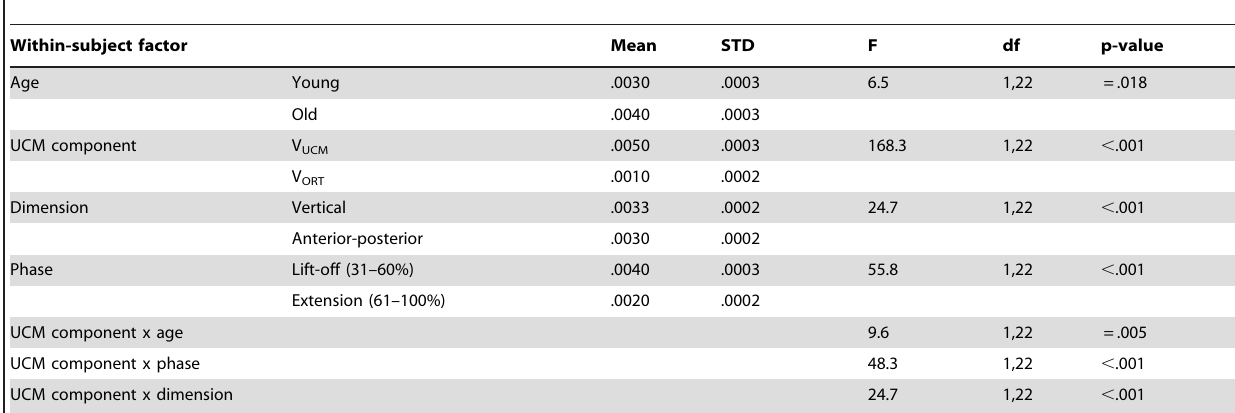
Table 3. Significant main and interaction effects of repeated measures ANOVA on variability per